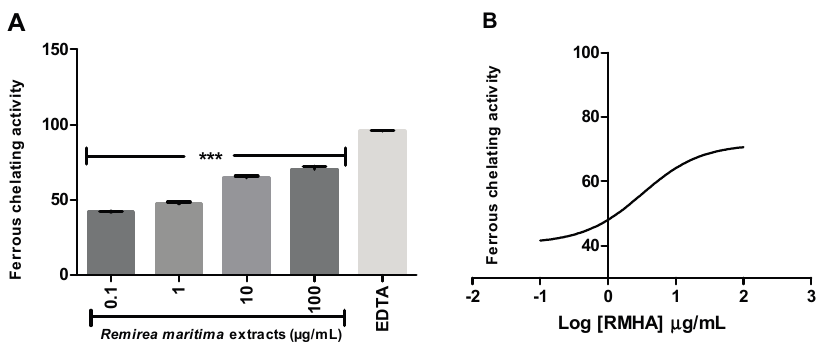
Figure 4. ( A ) The ability of RMHA extracts in prevent the Fe 2+ -ferrozine complex formation, thus decreasing the red color compared to control; ( B ) Log IC 50 graph. EDTA was used as standard chelating agent. Bars represent average ± SEM of three independent experiments. *** p < 0.001 (1-way ANOVA followed by Tukey’s post-hoc test).